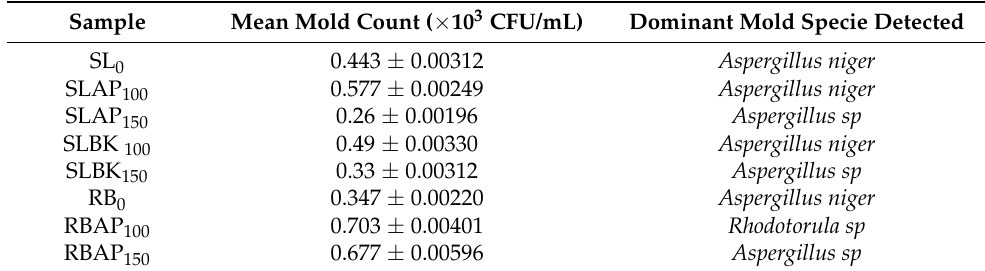
Table 3. Average fungi counts for different storage strategies and dominant mold species detected.